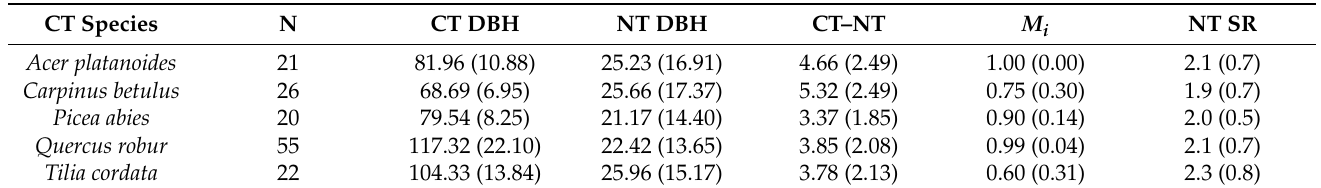
Table A1. Summary statistics of central trees (CT) and neighbour trees (NT) measured in the study: N—number of CTs measured; CT DBH—mean diameter at breast height ( ± Standard Deviation ( ± SD)) of the CT; NT DBH—mean diameter at breast height ( ± SD) of the NT; CT–NT—mean distance ( ± SD) between CT and NTs; M i —mean mingling index ( ± SD); NT SR—mean species richness ( ± SD) of neighbour trees around the CT. N CT DBH